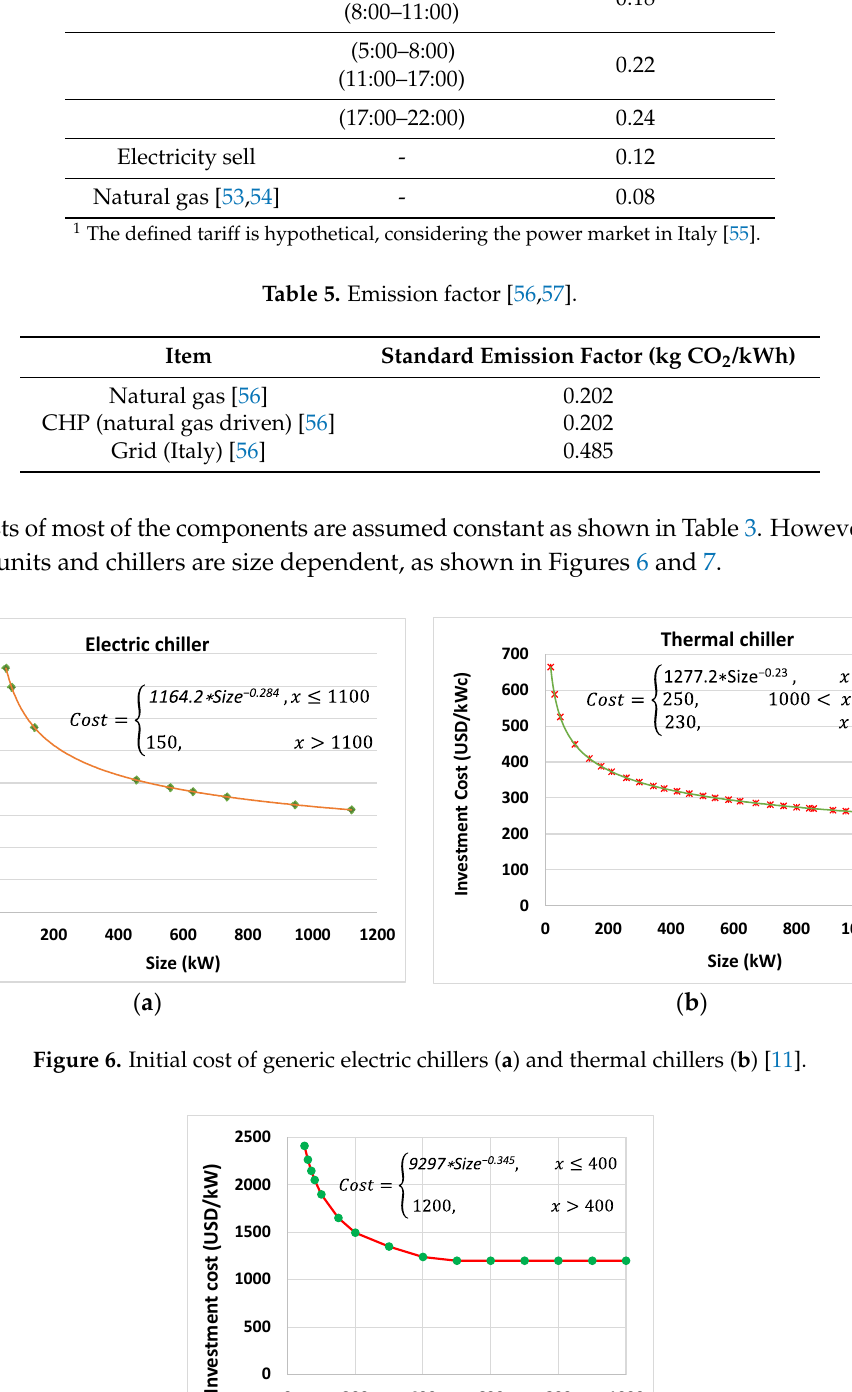
Figure 7. Initial cost of generic micro gas turbines [11].